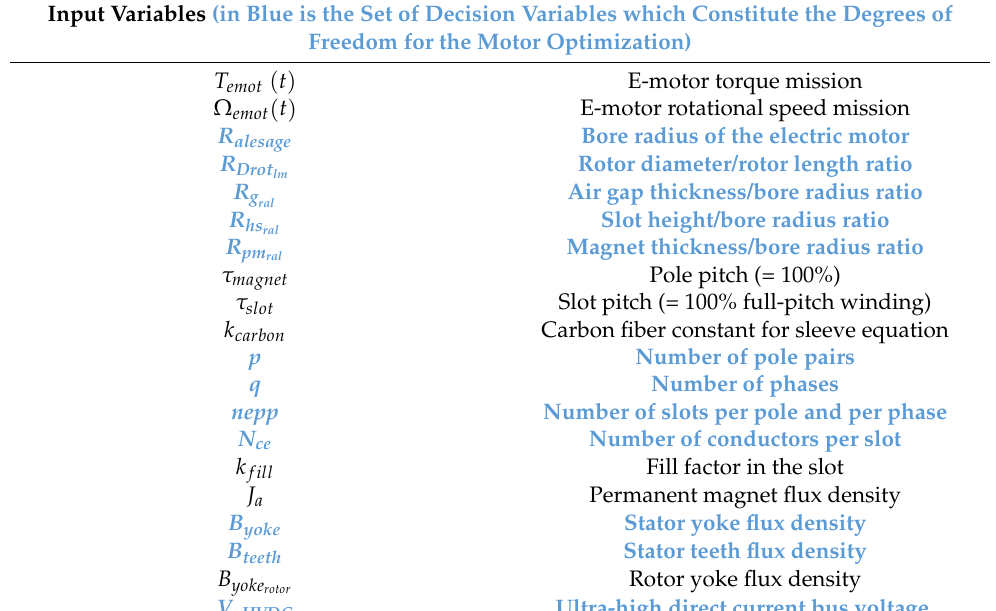
Figure 4. Electric motor cross-section. Table 1. Set of sizing variables.